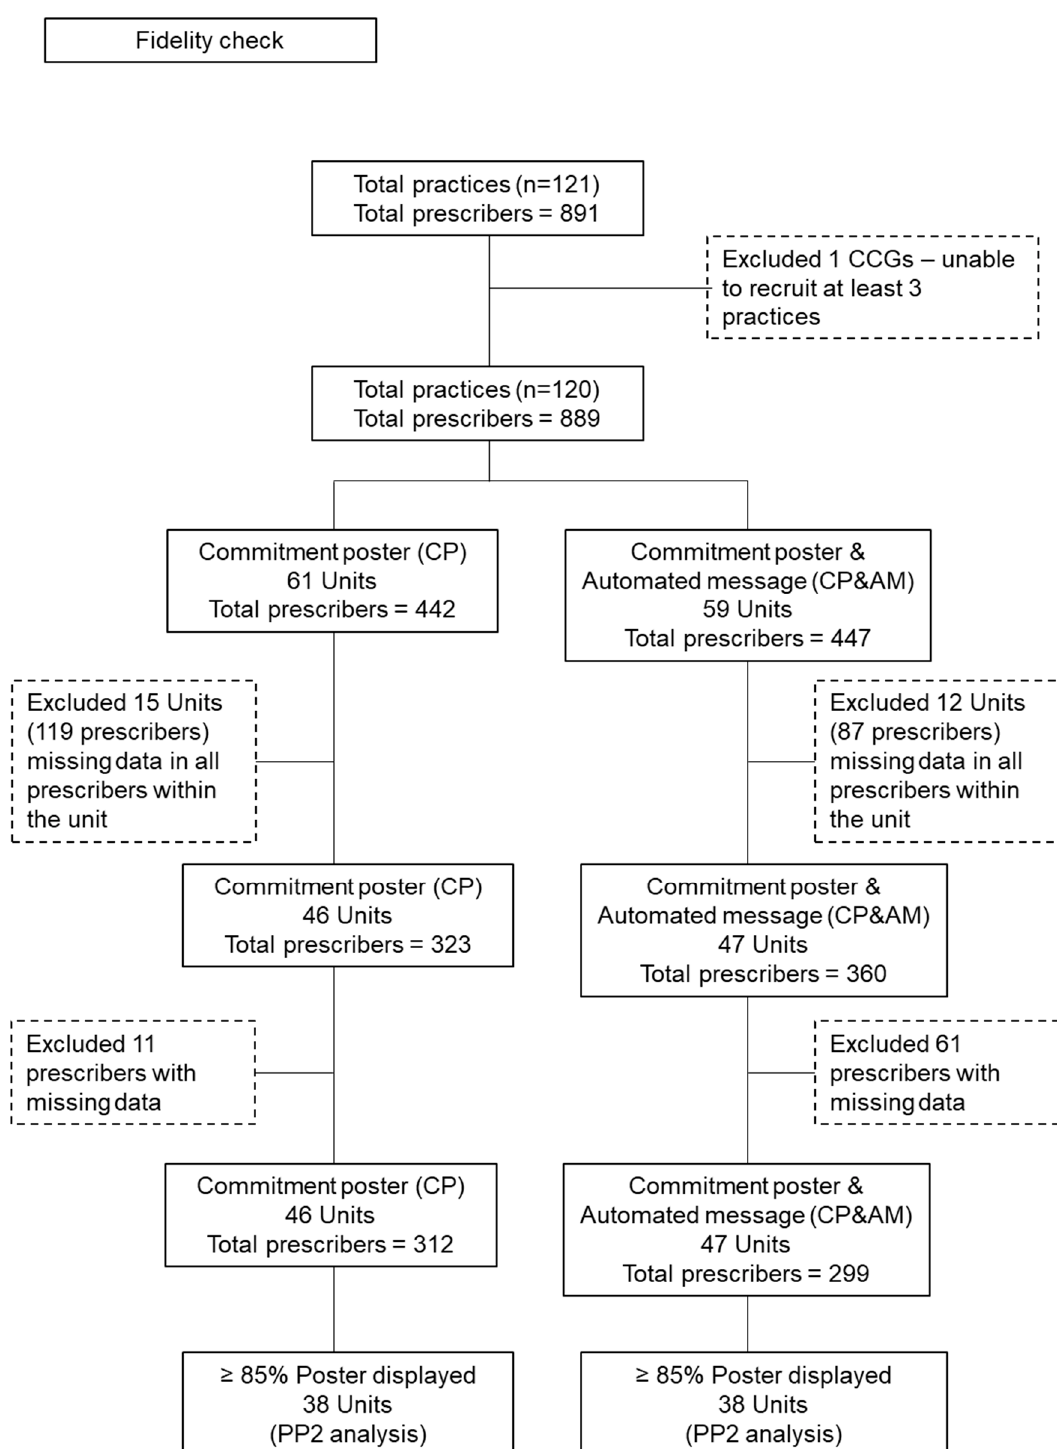
Figure 2. Responses to poster fidelity checks for the 889 participating GPs in the two trial arms.